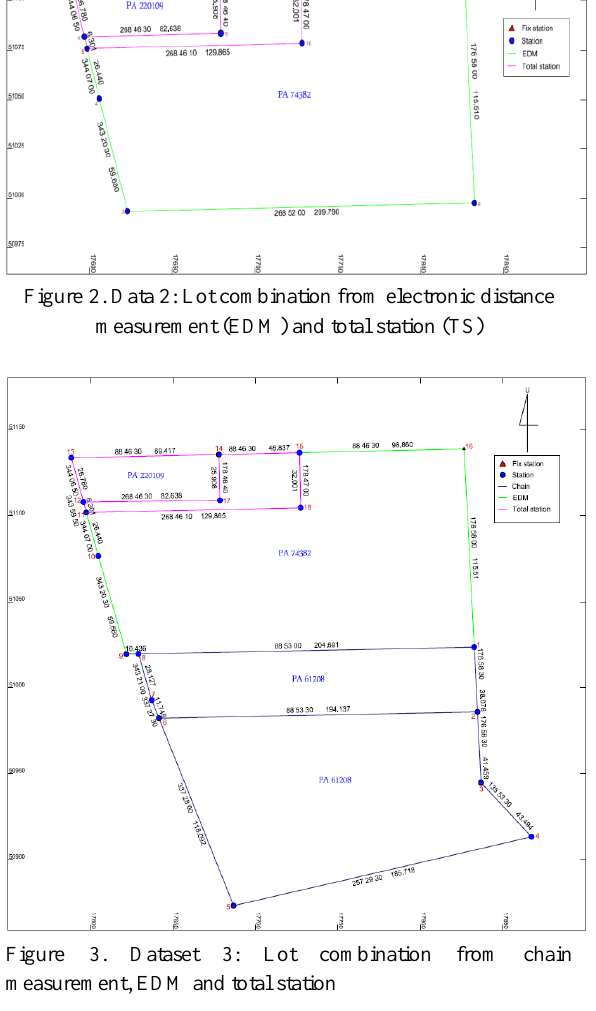
Figure 3. Dataset 3: Lot combination from chain measurement, EDM and total station